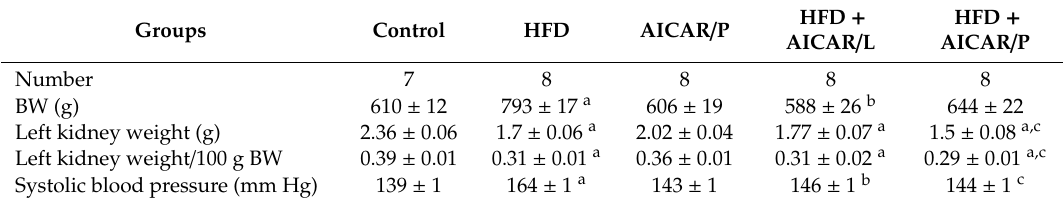
Table 2. Measures of body weight, kidney weight, and blood pressure in 16-week-old male o ff spring exposed to high-fat diet (HFD) and 5-aminoimidazole-4-carboxamide riboside (AICAR) in pregnancy or lactation. Groups Control HFD AICAR / P